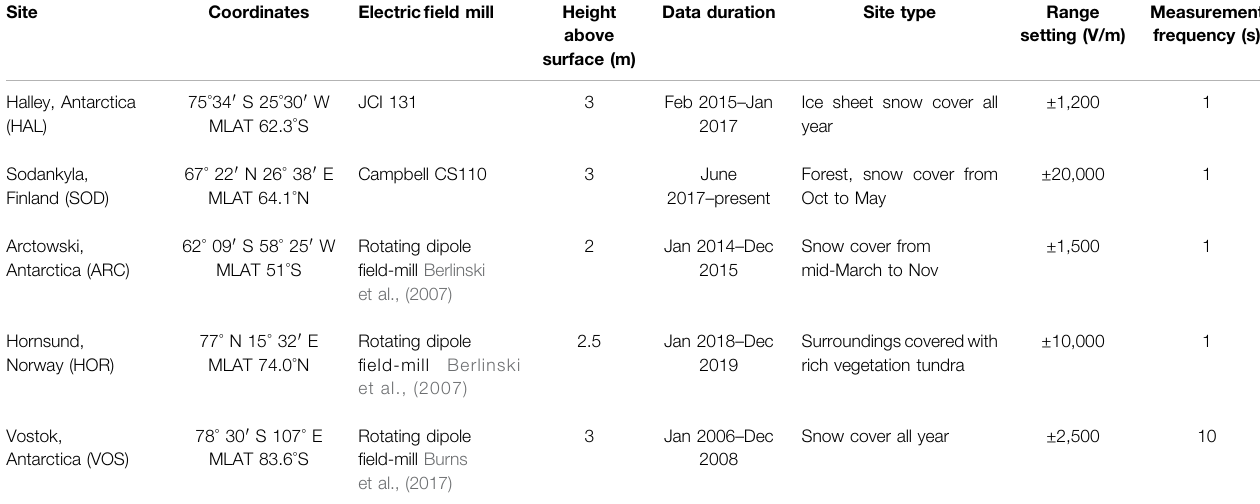
TABLE 1 | Details of the high latitude stations and instrumentation used to measure